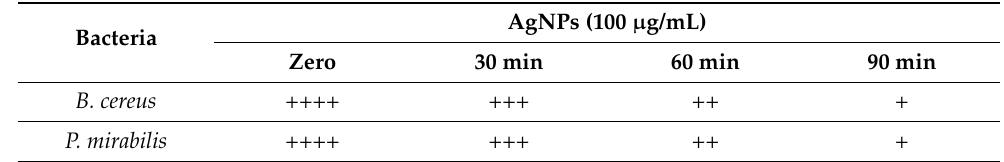
15 of 20 Figure 12. MIC and MBC of the AgNPs and AgNPs–lincomycin against bacterial isolate: ( A ) B. cereus